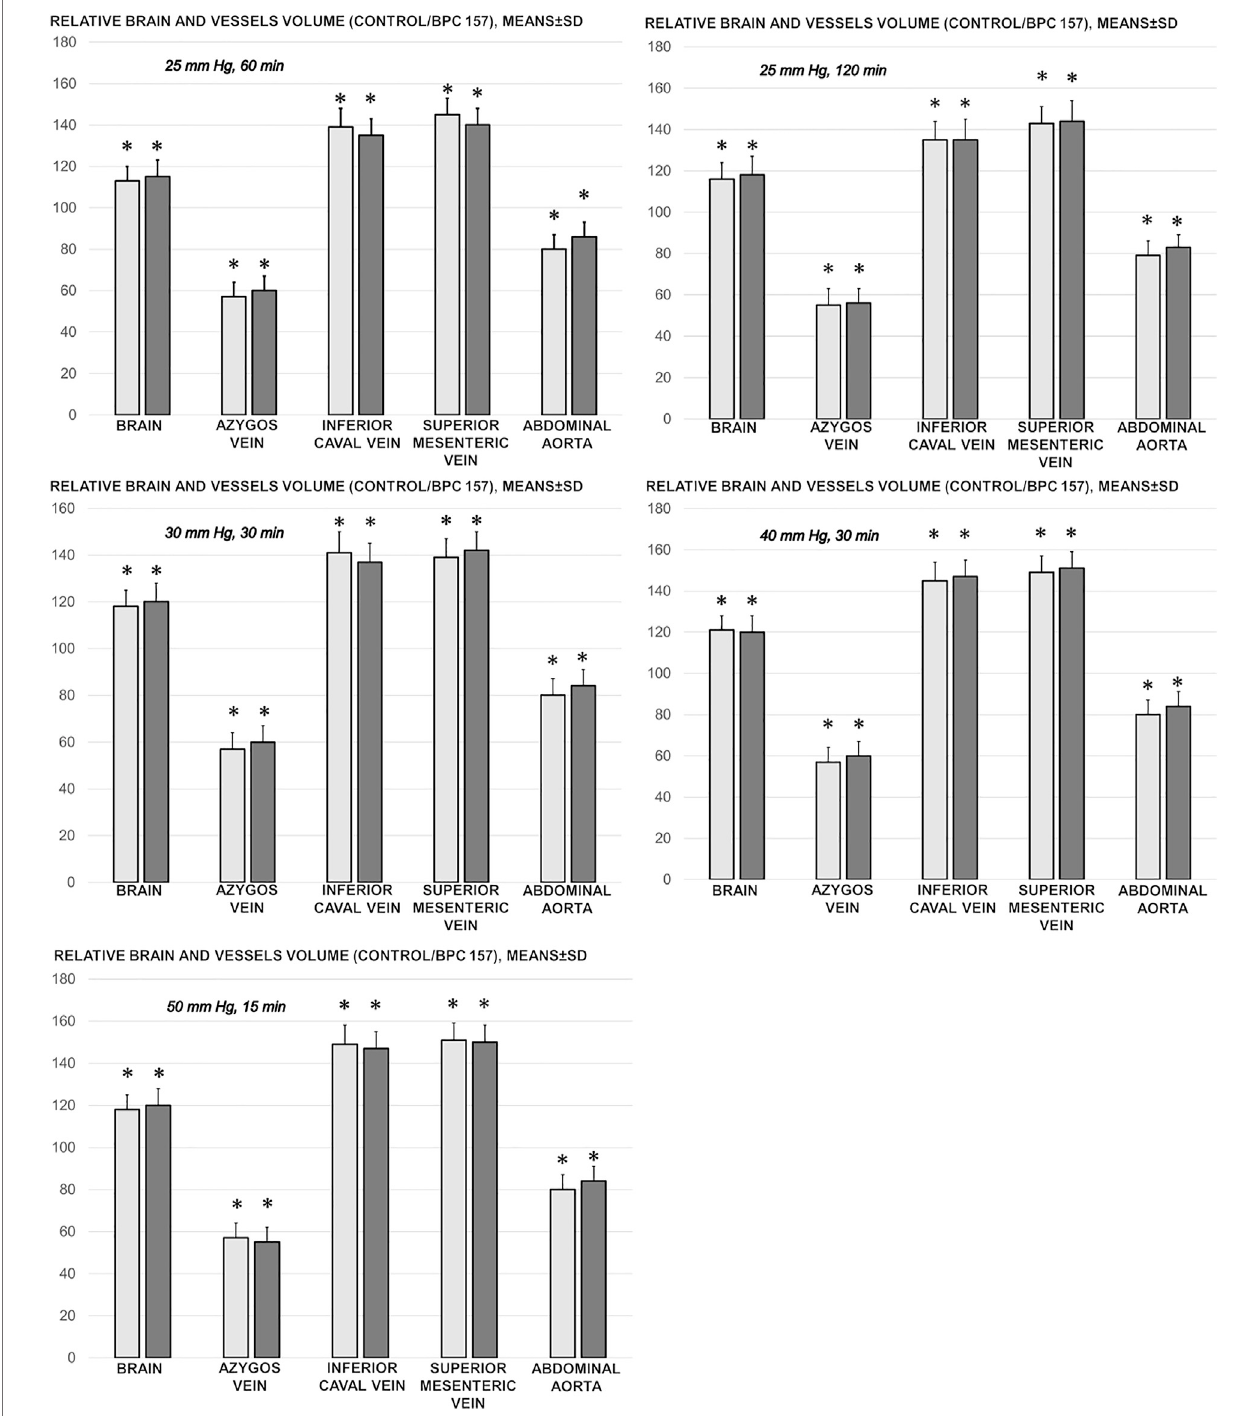
FIGURE 2 | Relative brain and vessels volume (volume control/volume BPC 157, %) in the thiopental-anesthetized rats with the increased intra-abdominal pressuresat 50 mmHgfor25 min, at 30 mmHgor 40 mmHgfor30 min,and at25 mmHgfor60 min increasedintra-abdominal pressures-time,and intheesketamine- anesthetized rats with the increased intra-abdominal pressures at 25 mmHg for 120 min increased intra-abdominal pressures-time, following medication (BPC 157 10 μ g/kg (light gray bars), 10 ng/kg (dark gray bars); saline 5 ml/kg (not shown, control/control as control, 100% for comparison)) given subcutaneously at 10 min increased intra-abdominal pressures-time. Means ± SD, *P ˂ 0.05, vs. control.